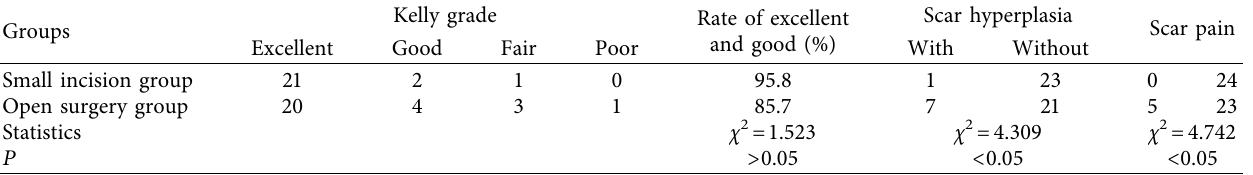
Table 4: Comparison of the Kelly grades and incidences of complications after the operation between the two groups of patients. Groups